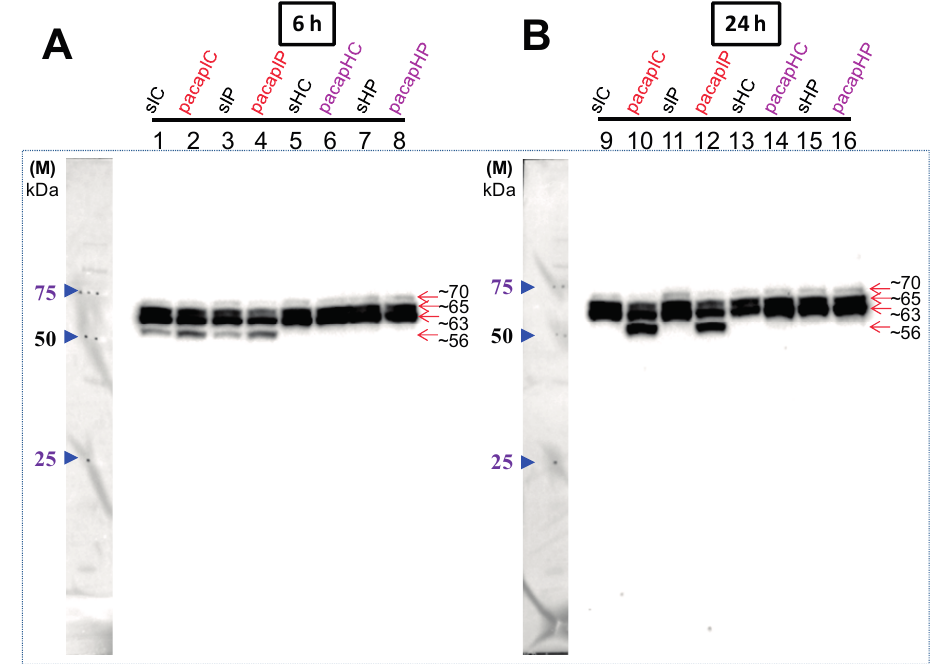
Figure 5. Western blot analysis of the CRMP2 protein cross-reacting proteins in ischemic core and penumbra of ipsilateral ( right ) hemisphere along with their abundance in corresponding regions in the healthy contralateral hemisphere ( left ). In ( A ), lane numbers 1 to 8 and in ( B ), lane numbers 9 to 16 indicate the 6 and 24 h samples, respectively. Abbreviations are the same as in Figure 2 legend. Proteins cross-reacting with the anti-CRMP2 protein antibody are visible as three constitutively present proteins (~70, ~65, and ~63 kDa size) in all samples. The ~56 kDa cross-reacting protein is seen not only in the ischemic core but also in the penumbra. Total protein extraction, separation, Western blotting, and image analyses procedures are detailed in Materials and